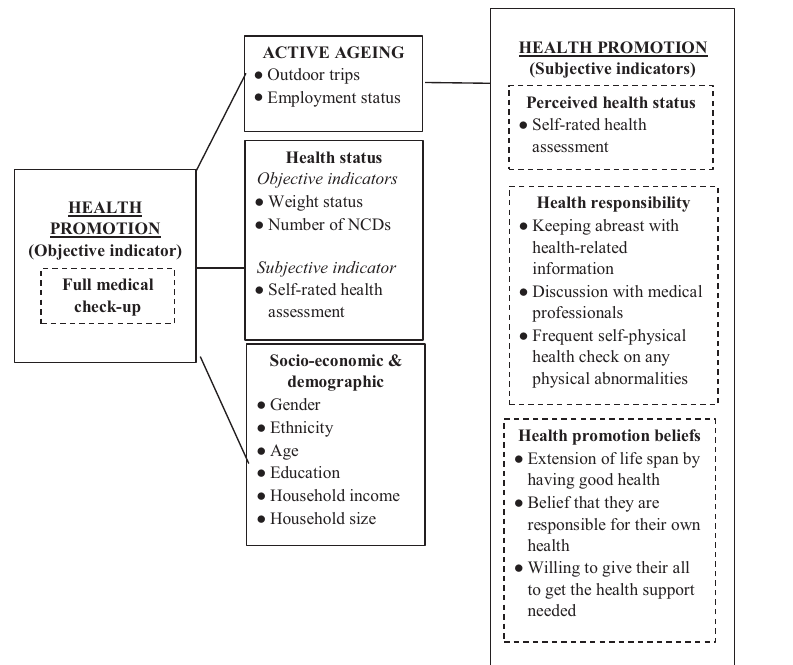
Figure 1. Analytical